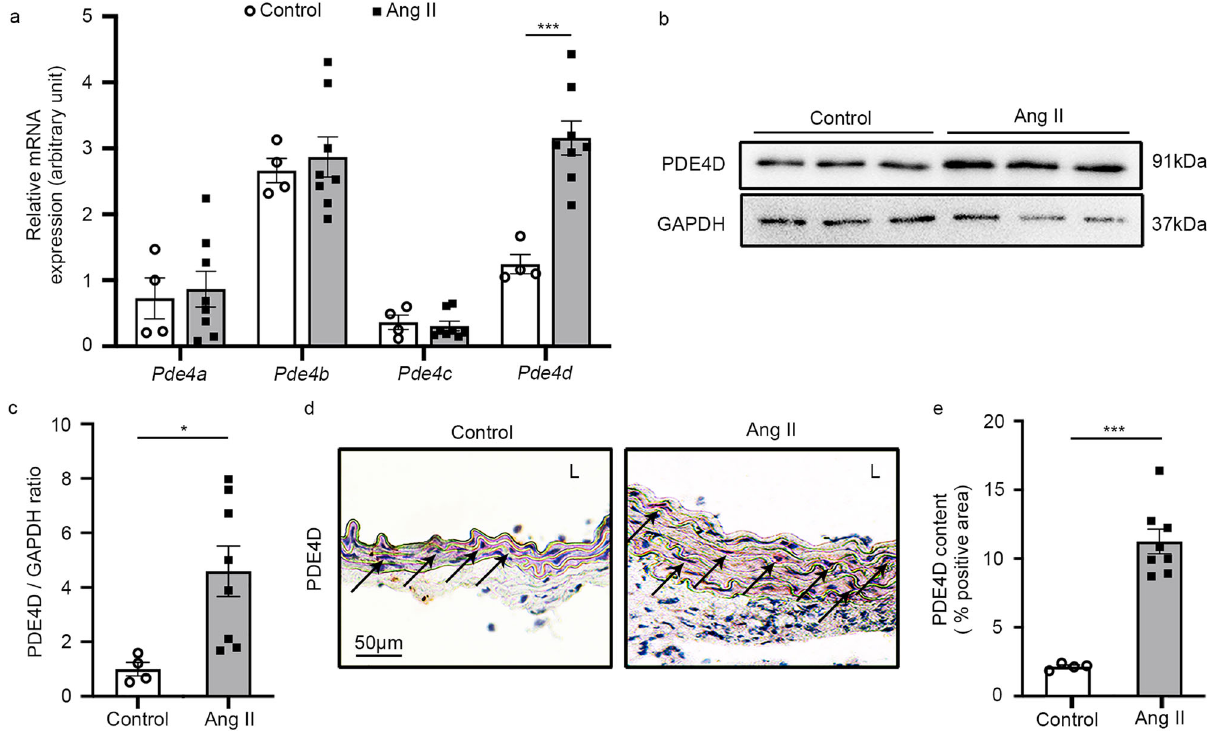
Fig. 1 PDE4D expression is upregulated in hypertensive mice. a Real-time polymerase chain reaction (RT-PCR) was used to measure mRNA expression of PDE4A, PDE4B, PDE4C, and PDE4D in the aorta tissues of control mice and hypertensive mice (fold change vs. one of controls). b Representative western blot showing PDE4D expression in aorta tissues. c Quanti fi cation of PDE4D expression normalized to glyceraldehyde-3-phosphate dehydrogenase (GAPDH) protein. d Representative immunohistochemical staining of PDE4D. Arrows indicate positive areas. e Quanti fi cation of the percentage of PDE4D- positive area. n = 4 in control group, n = 8 in hypertensive group. Data are expressed as mean ± standard error of mean (SEM). Two-tailed Student ’ s t test was performed to compare differences between two groups. * p < 0.05, *** p < 0.001. L